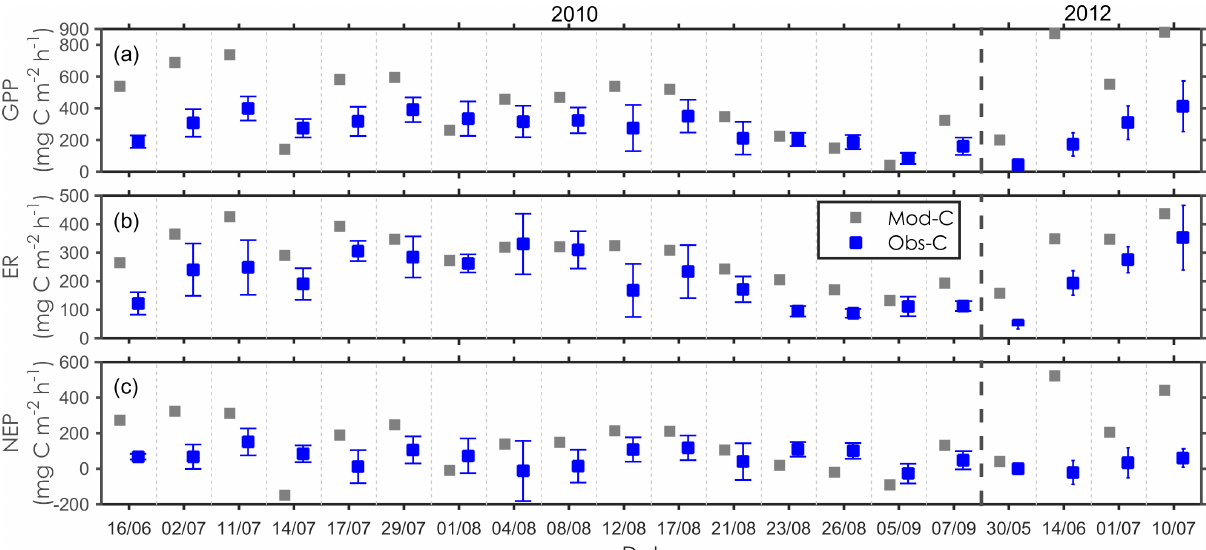
Figure 2. Modelled (grey) and observed (blue) gross primary production (GPP, a ), ecosystem respiration (ER, b ), and net ecosystem pro- duction (NEP, c ) for the growing season of 2010 and 2012 in the control plots at the Abisko tundra heath. Error bars indicate the standard deviation for the six